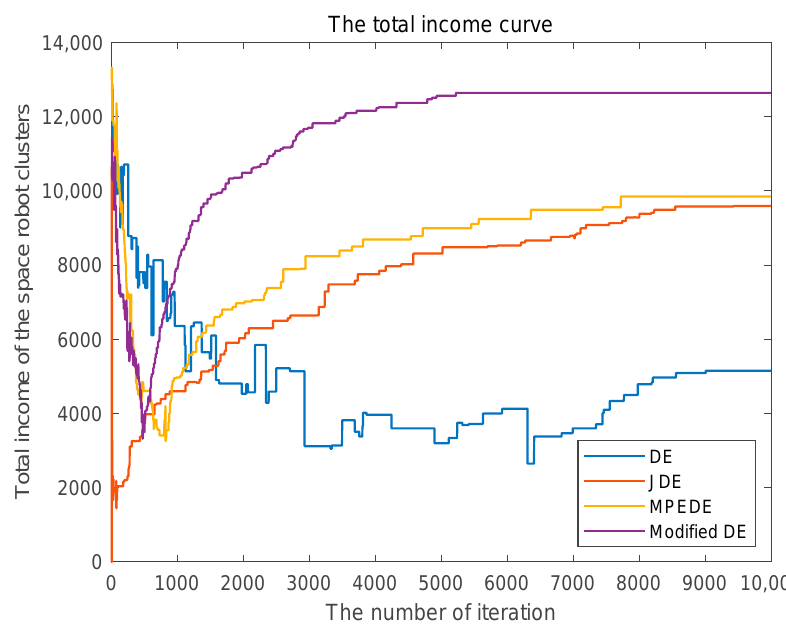
Figure 6. Total income when the space-robot cluster energy is 6000.